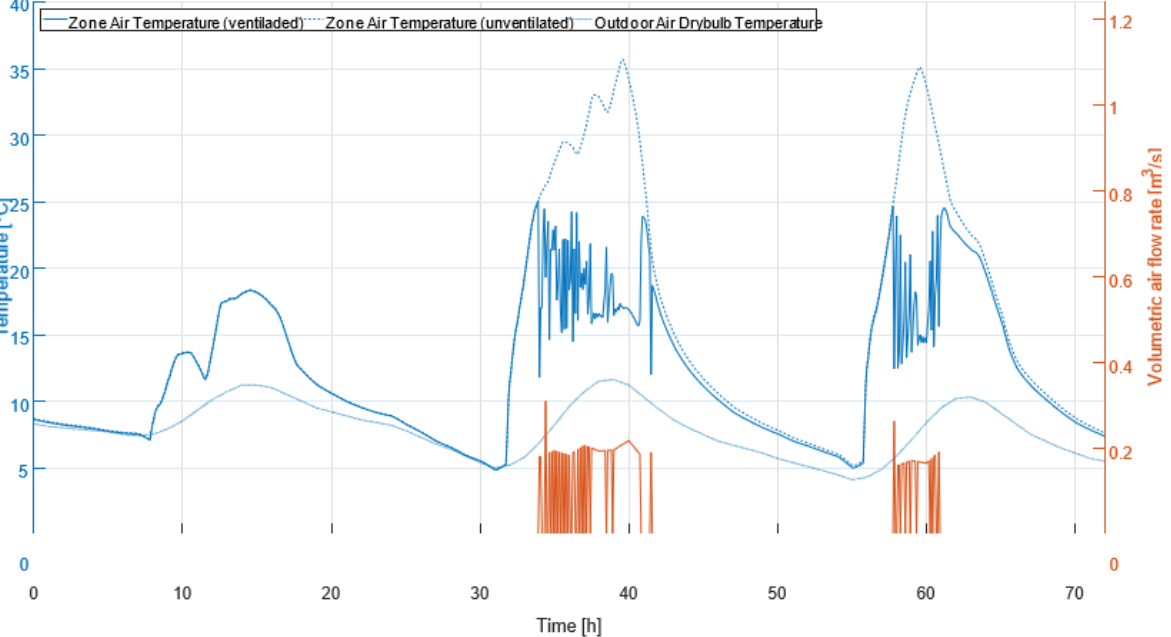
Figure 10. Unconditioned, naturally ventilated and outside temperature of the greenhouse between the 29 and 31 January.